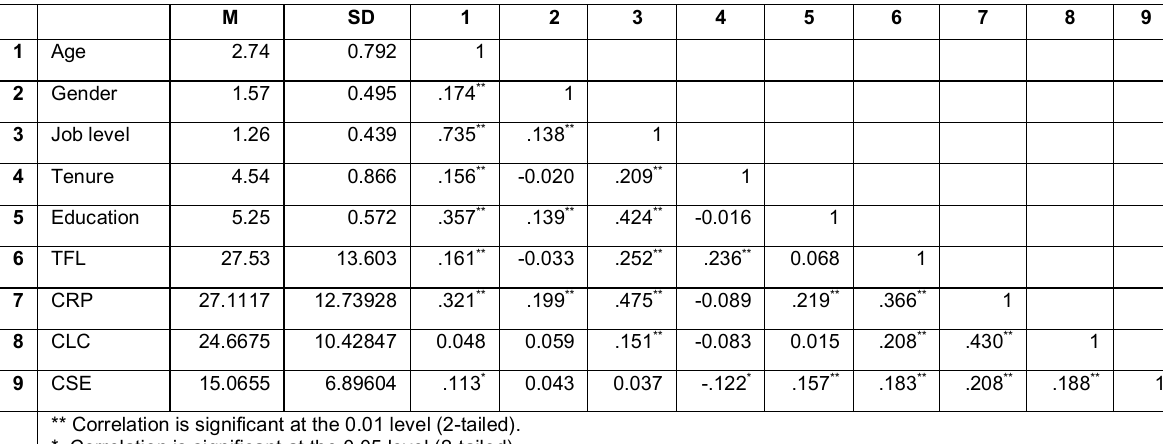
Table 6: Descriptive Statistics and